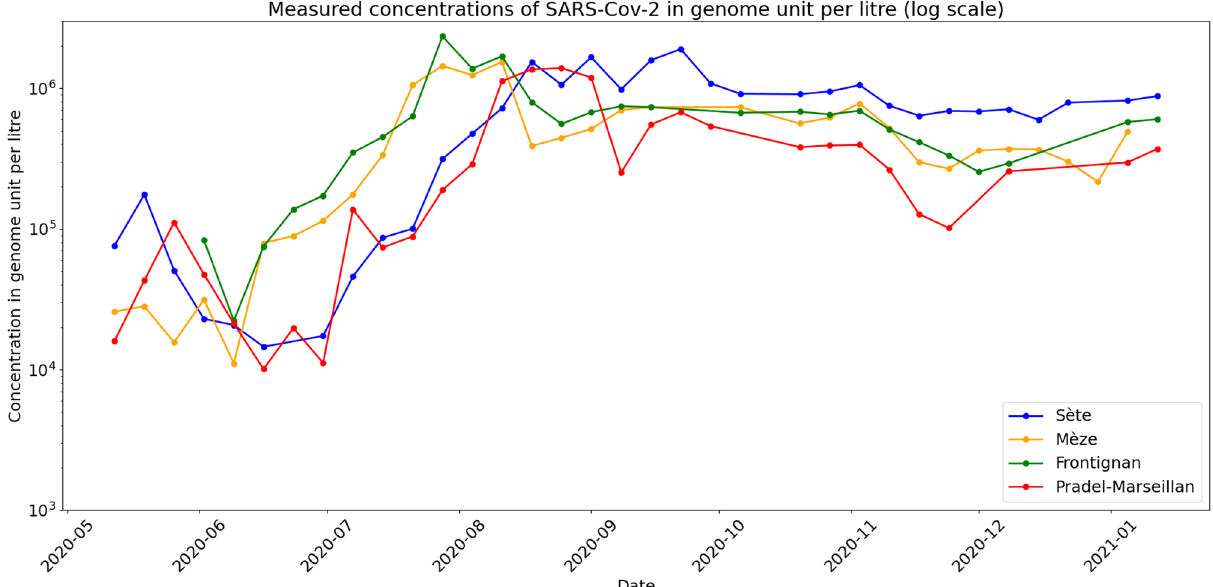
Figure 1. Concentrations of SARS-CoV-2 (genome units per litre in logarithmic scale) from four WWTPs in Thau lagoon, measured weekly with dPCR technology from May 12th 2020 to January 12th, 2021. Note that there are some missing